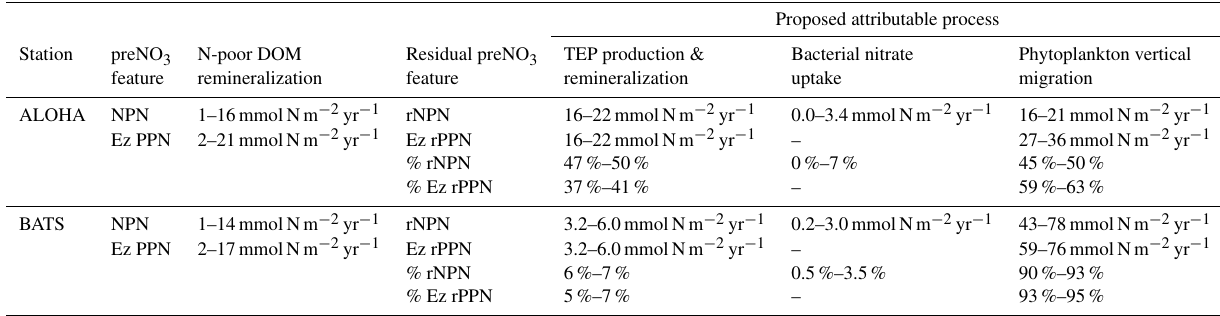
Table 2. Contribution of N-poor DOM remineralization to NPN and PPN anomaly formation rates as well as contributions to rNPN and rPPN anomaly formation rates by presumed processes at the time series sites. NPN and rNPN is for features on γ n = 24 . 2–25.2 at Station ALOHA and γ n = 25 . 8–26.3 at the BATS station. Ez PPN and rPPN is for features at 0–100m depth at Station ALOHA and 0–80m depth at the BATS